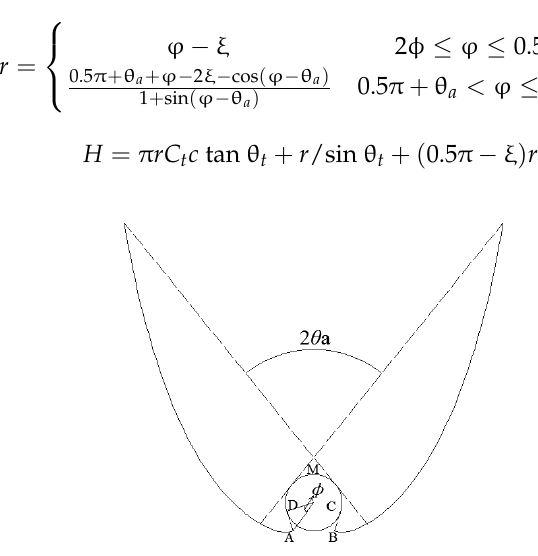
Figure 6. CPC ‐ 5, designed based on “hat” absorber. Figure 6. CPC-5, designed based on “hat”